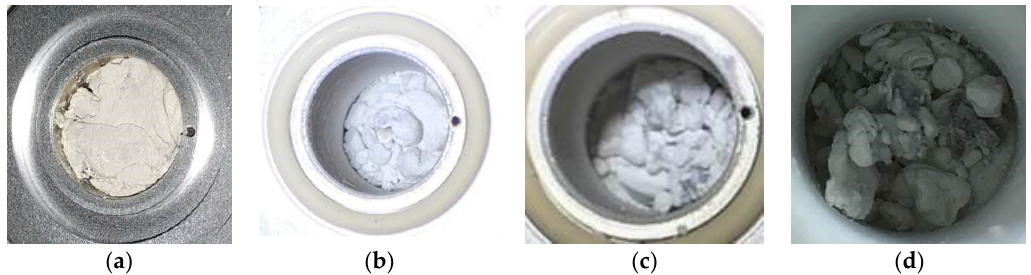
Figure 11. Photographs of the BN-124 target post-irradiation at ( a ) 1 μ A; ( b ) 3 μ A; ( c ) 5 μ A; and ( d ) 8 μ A.